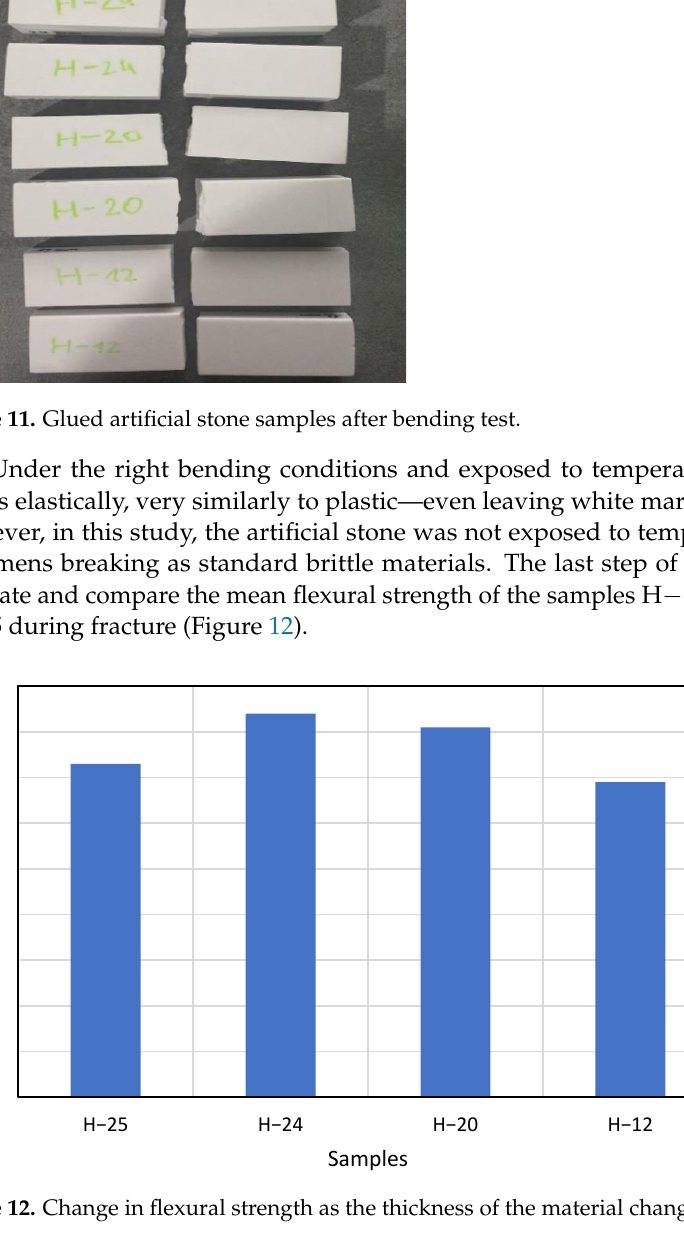
Figure 12. Change in flexural strength as the thickness of the material changes. Data in Figure 12 shows that the H − 25 gluing method has the lowest flexural strength value compared to other gluing methods. This is due to the design solutions of the prod- uct. The assembly of this gluing method contains a vertical part at the bending point, which prevents the product from bending and causes the specimen to break faster. Thus, the gluing area of this sample is the smallest compared to other samples. In the experi- mental studies, it was observed that the H − 24 and H − 20 samples had a high resistance to